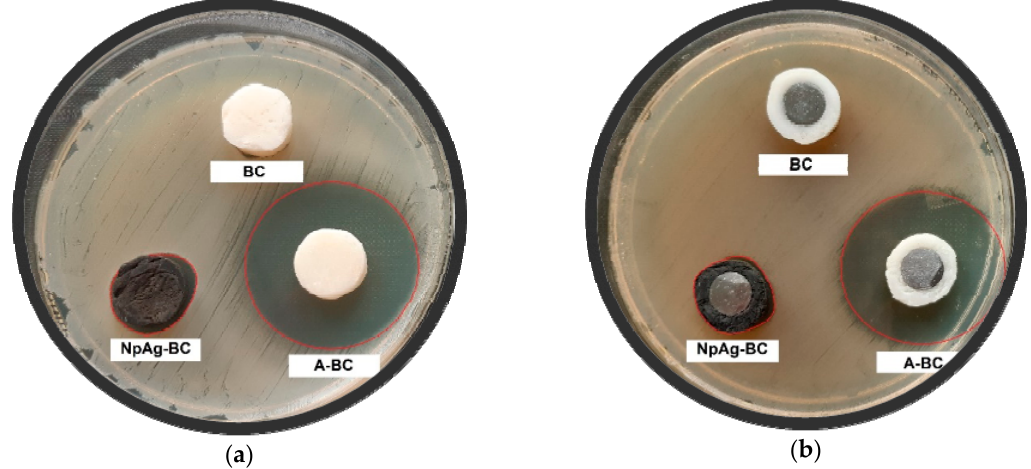
Figure 7. Bacterial growth inhibition on untreated SLM titanium alloy specimens coated with bone cements: unmodified (BC), antibiotic-loaded (A-BC) and modified with nanosilver (NpAg-BC) after 7 days of bacteria culture (the presented pictures are representative for three experiments): ( a ) Staphylococcus aureus and ( b ) Escherichia coli.